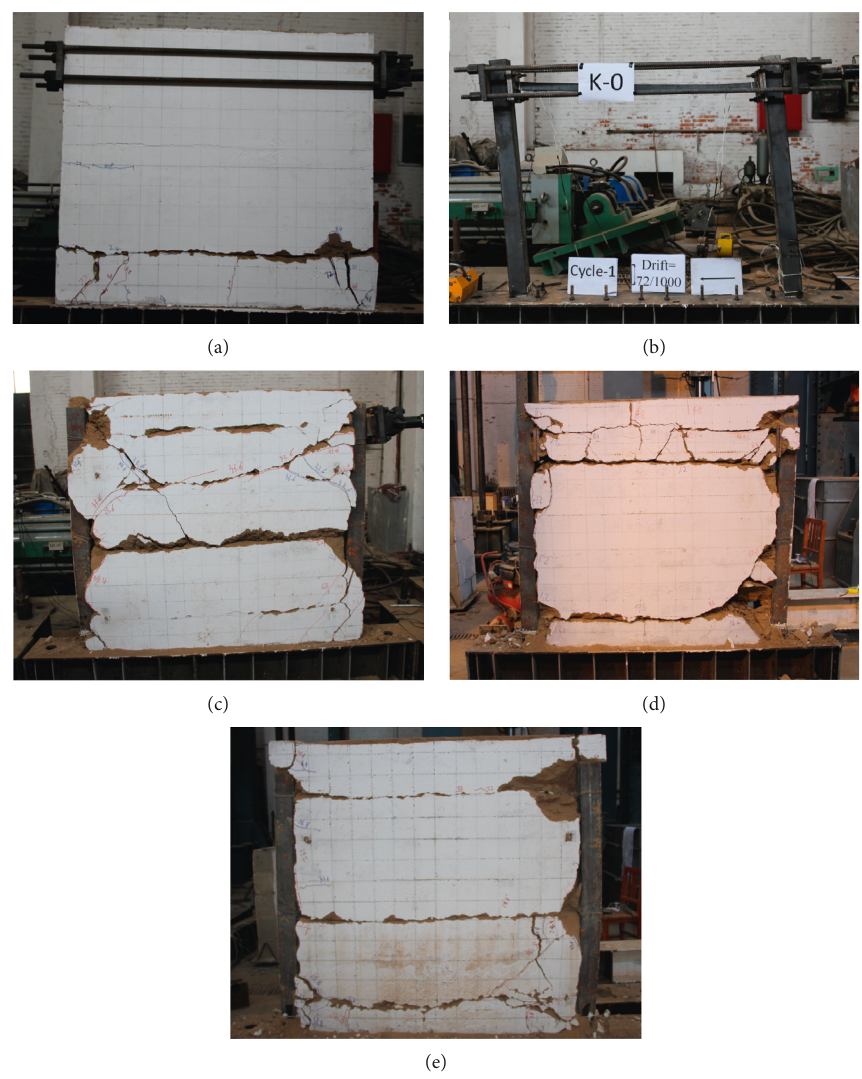
Figure 8: Failure patterns of tested specimens. (a) Specimen Q-1. (b) Specimen SF. (c) Specimen W-1. (d) Specimen W-2. (e) Specimen